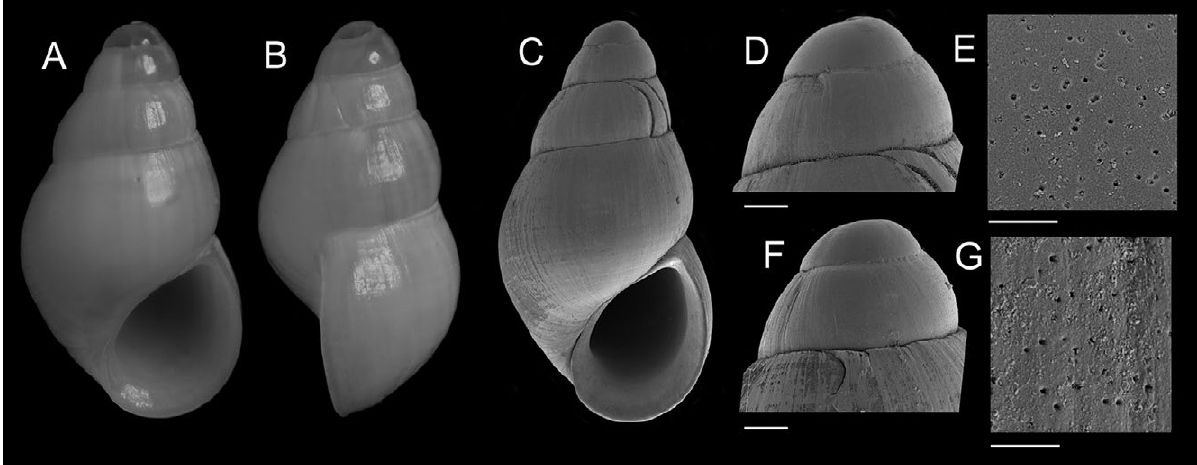
Fig. 3. – Onoba goyoi . A-B, holotype, INDEMARES/CHICA 0610 BC11, 477 m depth (2.15 mm); C, SEM micrograph of the holotype; D, SEM micrograph of the protoconch of the holotype (scale bar 100 μm); E, SEM micrograph of the microsculpture of the teleoconch, holotype (scale bar 10 μm); F, protoconch of a paratype (BC11.3) (scale bar 100 μm); G, SEM micrograph of the microsculpture, same specimen (scale bar 10 μm). BC,